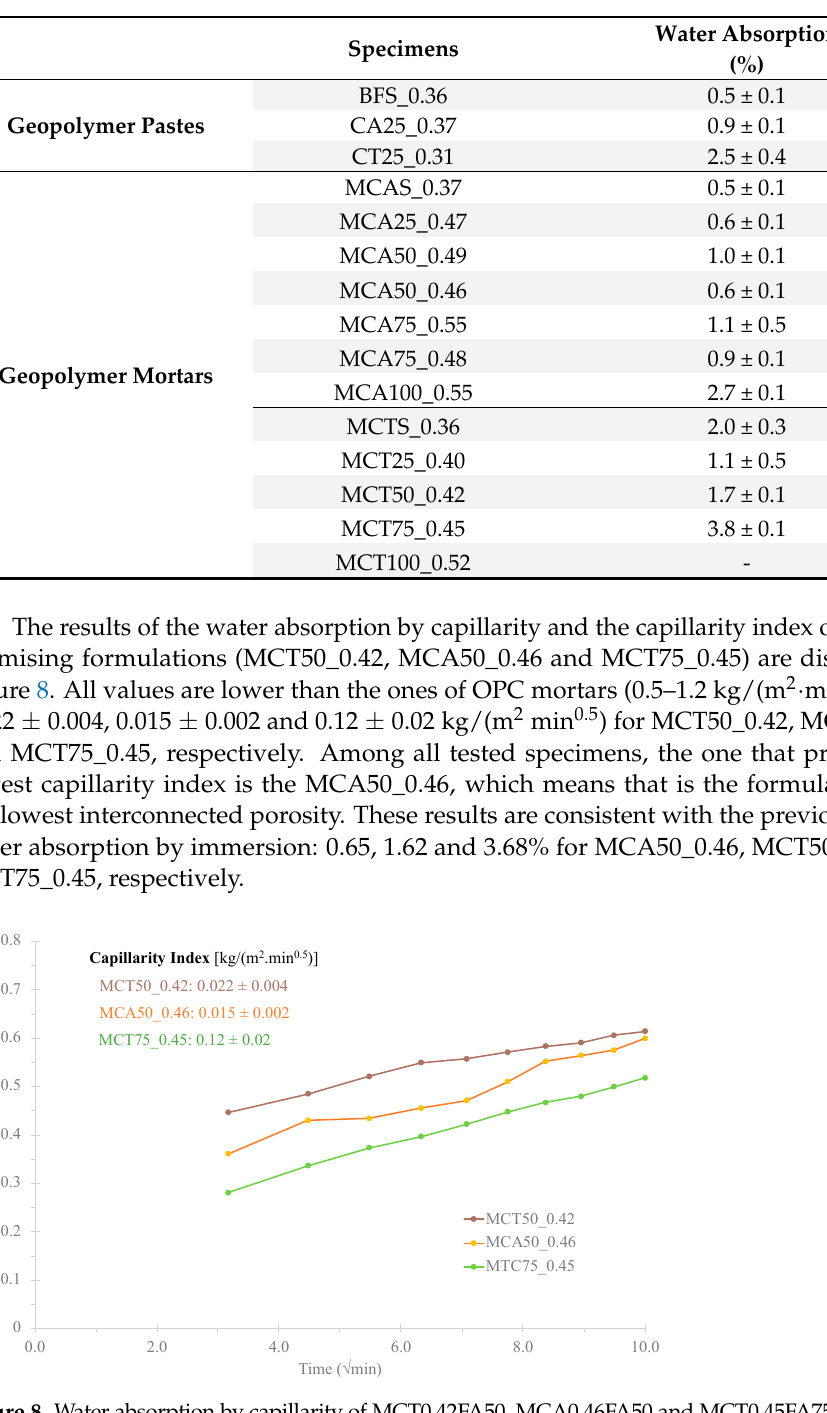
Figure 8. Water absorption by capillarity of MCT0.42FA50, MCA0.46FA50 and MCT0.45FA75 specimens.